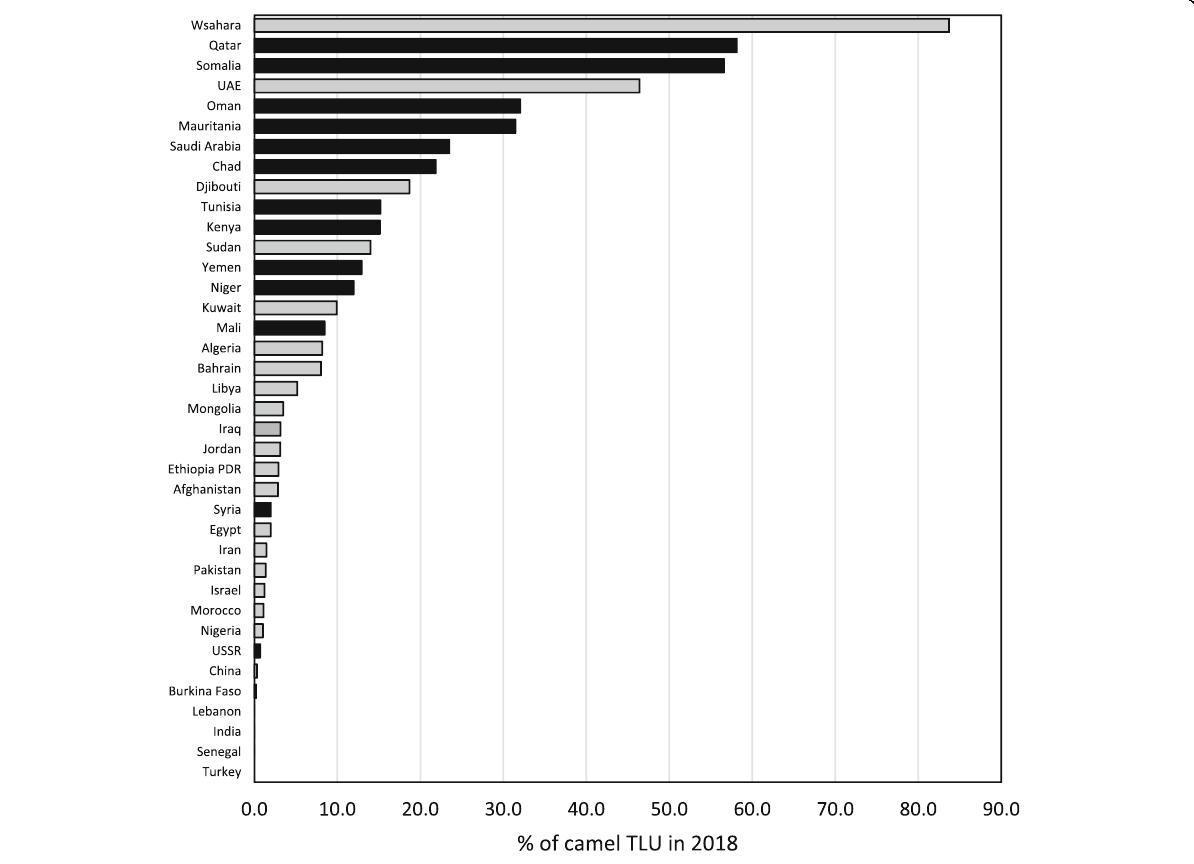
Fig. 2 Percentage of camel stock in the total TLU in camel countries in 2018. In grey, the countries with decreasing percentage since 1961. In black, the countries with increasing percentage since 1961